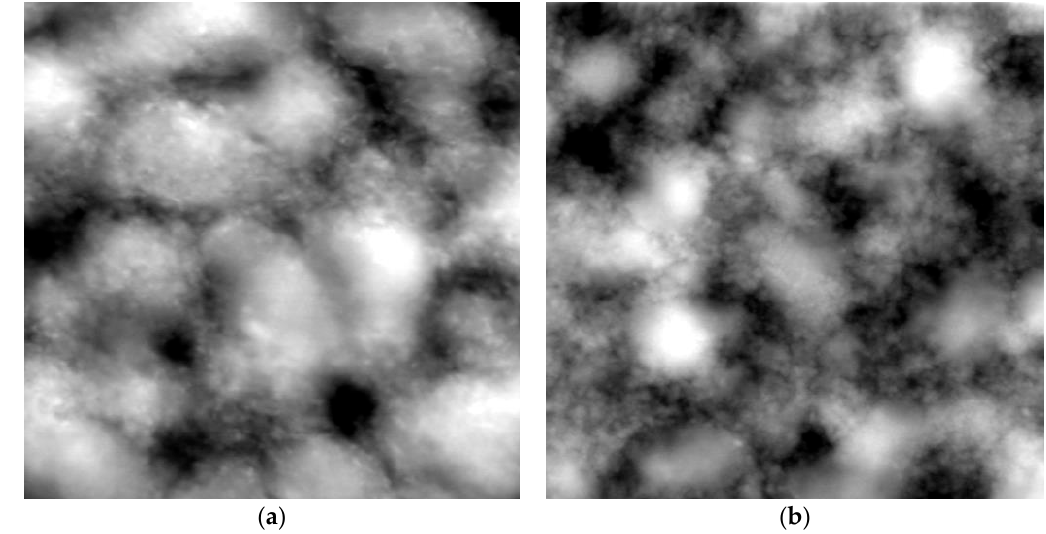
Figure 4. SFM images (4 × 4 µ m 2 , topography) of PNIPAM-DMAEMA/CS-1.2 coatings deposited at T = 50 °C and pH = 4 onto Si substrate. ( a ) Initial state before rinsing with pure water; ( b ) state after rinsing with pure water.